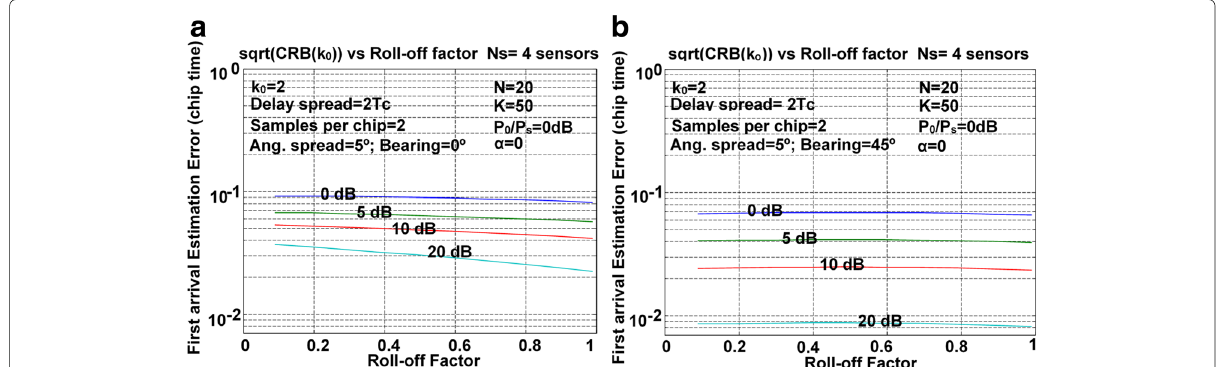
Fig. 11 CRB of k 0 as a function of the roll-off factor of the shaping pulse. Results are provided for different values of the dispersed SNR when the LOS power level is 0 dB higher than the dispersed signal and an ICD source ( α = 0). 50 channel vector estimates are available. The sampling rate set to twice the chip rate, delay spread set to 2 T c , angular spread set to 5°, and four sensors. a Left: bearing = 0°. b Right: bearing =